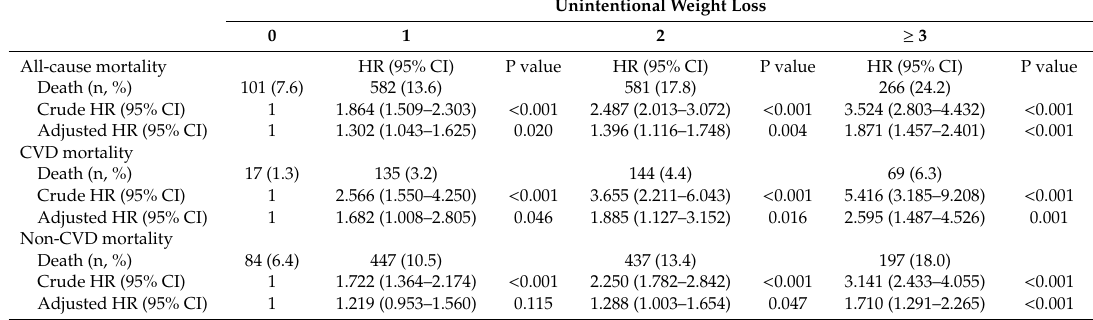
Table 5. Risk of mortality during 10 years of follow-up according to a number of lifestyle risk factors at the